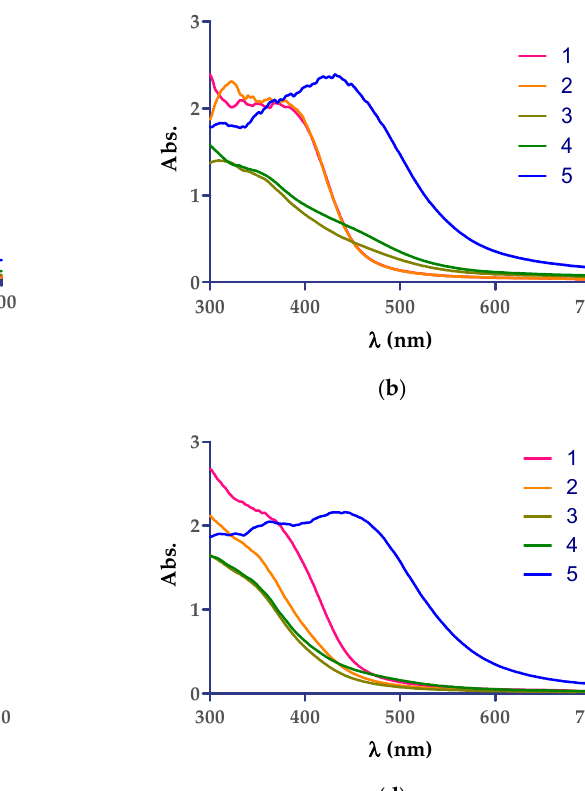
Table 4. The main recorded FT-IR ATR bands on 4000- 600 cm − 1